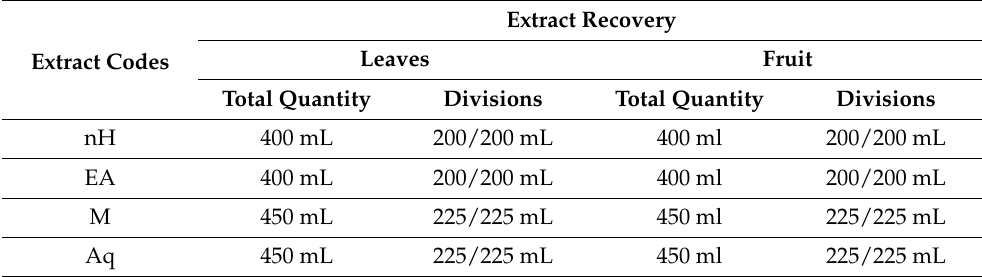
Table 1. Extract recovery of different parts of C. colocynthis . Extract Recovery Leaves Fruit Extract Codes Total Quantity Divisions Total Quantity Divisions nH 400 mL 200/200 mL 400 ml 200/200 mL 200/200 mL 400